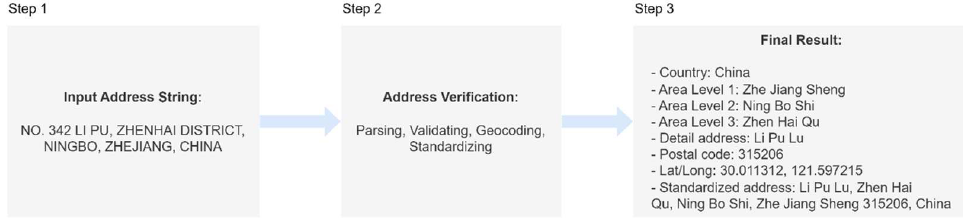
Figure 1. Address verification [7].